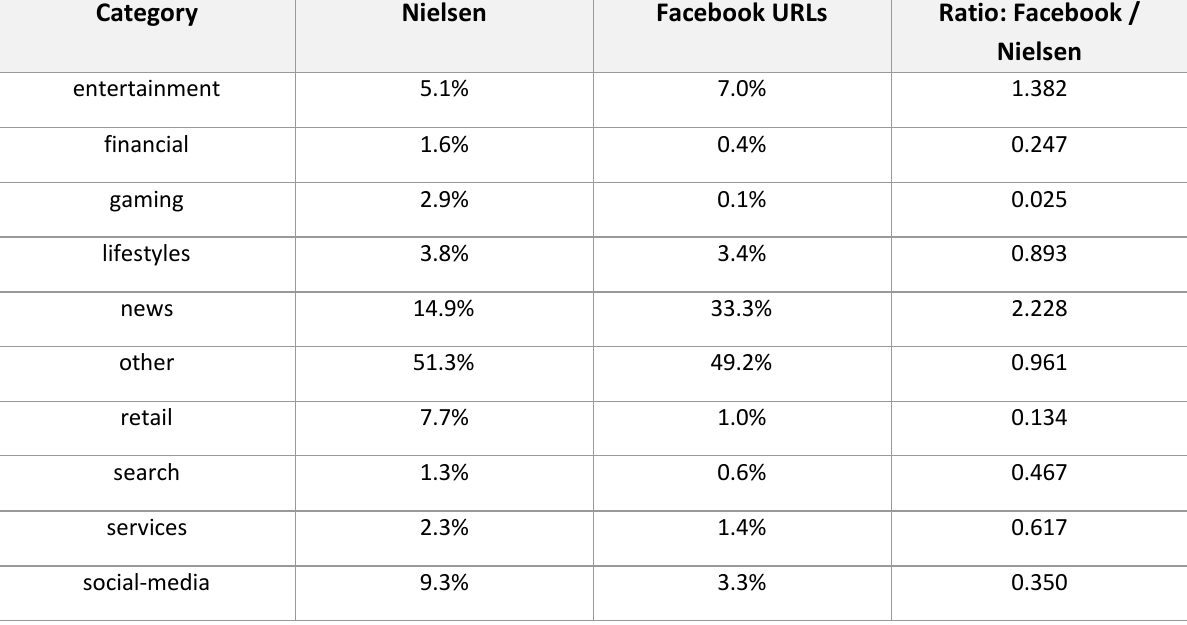
Table A2. Estimated percentage of clicks on Facebook for different categories of URLs, comparing the Nielsen and Facebook URLs